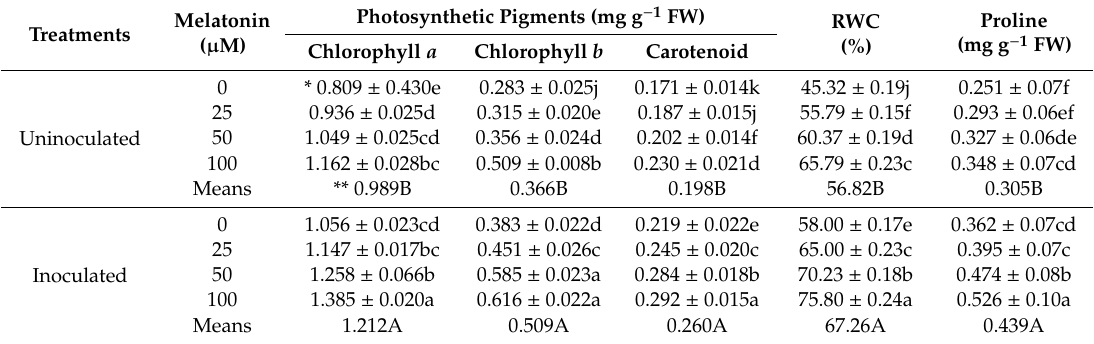
Table 6. E ff ect of EPS-producing bacteria and melatonin on photosynthetic pigments, relative water content (RWC)%, and proline content of faba bean plants grown in location one (saline soil).